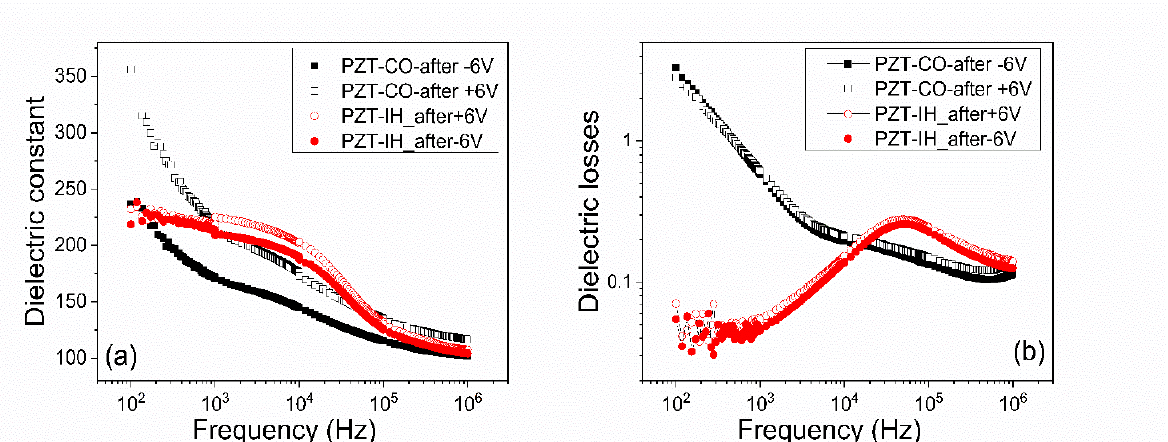
Figure 6. The frequency dependence of ( a ) capacitance and ( b ) dielectric losses for the PZT films deposited from commercial target (PZT-CO) and in-house made, pure target (PZT-IH). The measurements were performed at room temperature using an ac voltage of 0.1 V amplitude. The samples were first poled to fix the polarization state; then the poling voltage was removed, and the measurements started without any dc voltage applied on the sample.